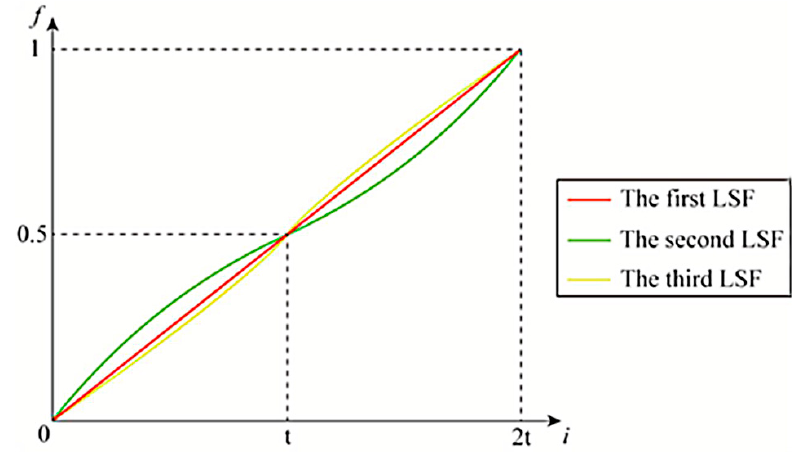
Figure 2. Graphical representation of three LSFs.